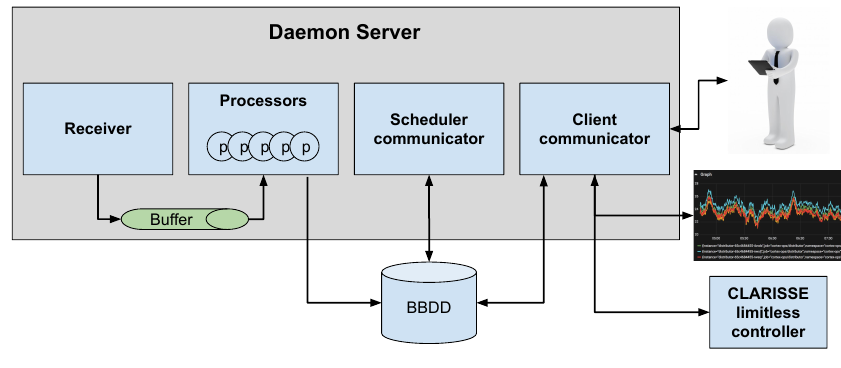
Figure 3. LIMITLESS server